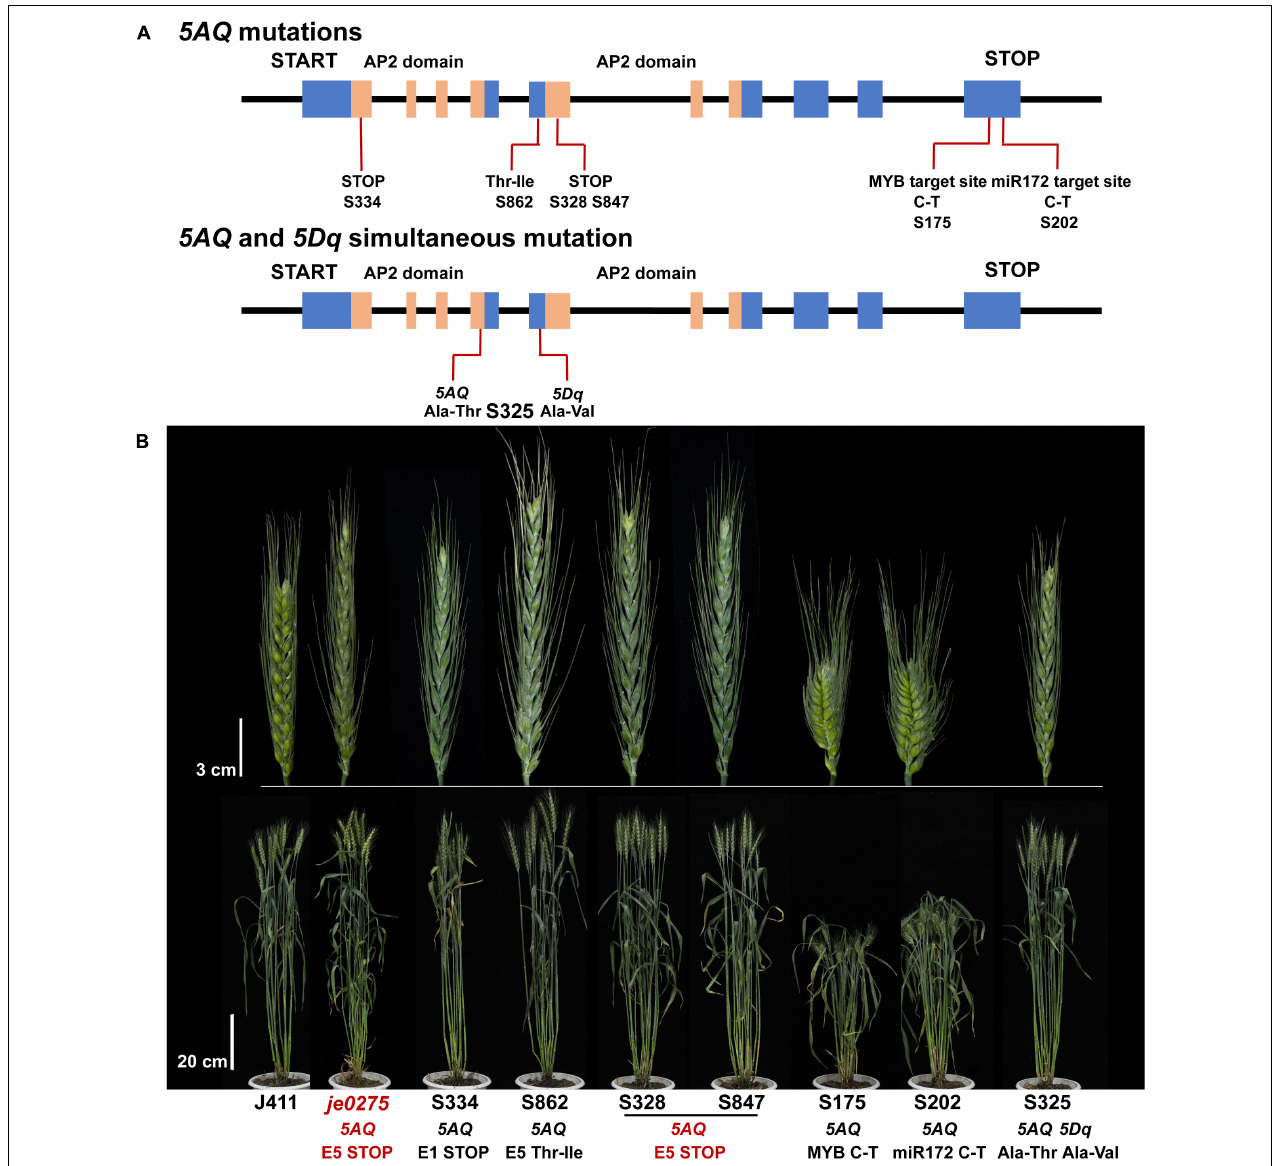
FIGURE 5 | Identification of mutations in the Q gene. (A) The mutation sites and predicted translational changes in mutants are marked in the schematic representation of the Q gene. The blue rectangles indicate exons, the orange rectangles indicate the AP2 domains, and the black lines indicate introns of the Q gene. (B) Phenotype of mutants that had mutations in the Q gene at the heading stage. Bars, 3 cm (upper) and 20 cm